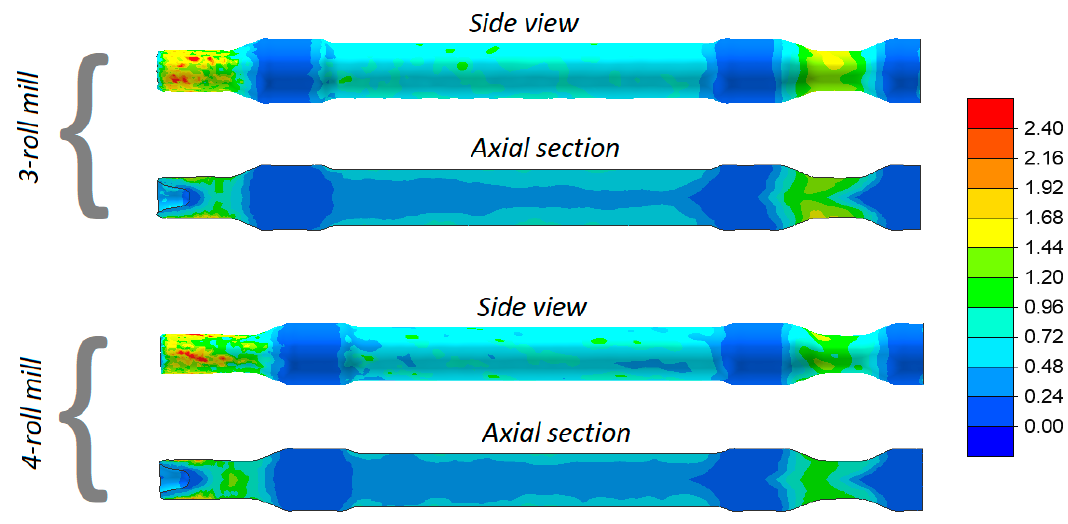
Figure 8. Distribution of the damage function (based on the normalized Cockcroft–Latham ductile fracture criterion) in skew rolled axles.